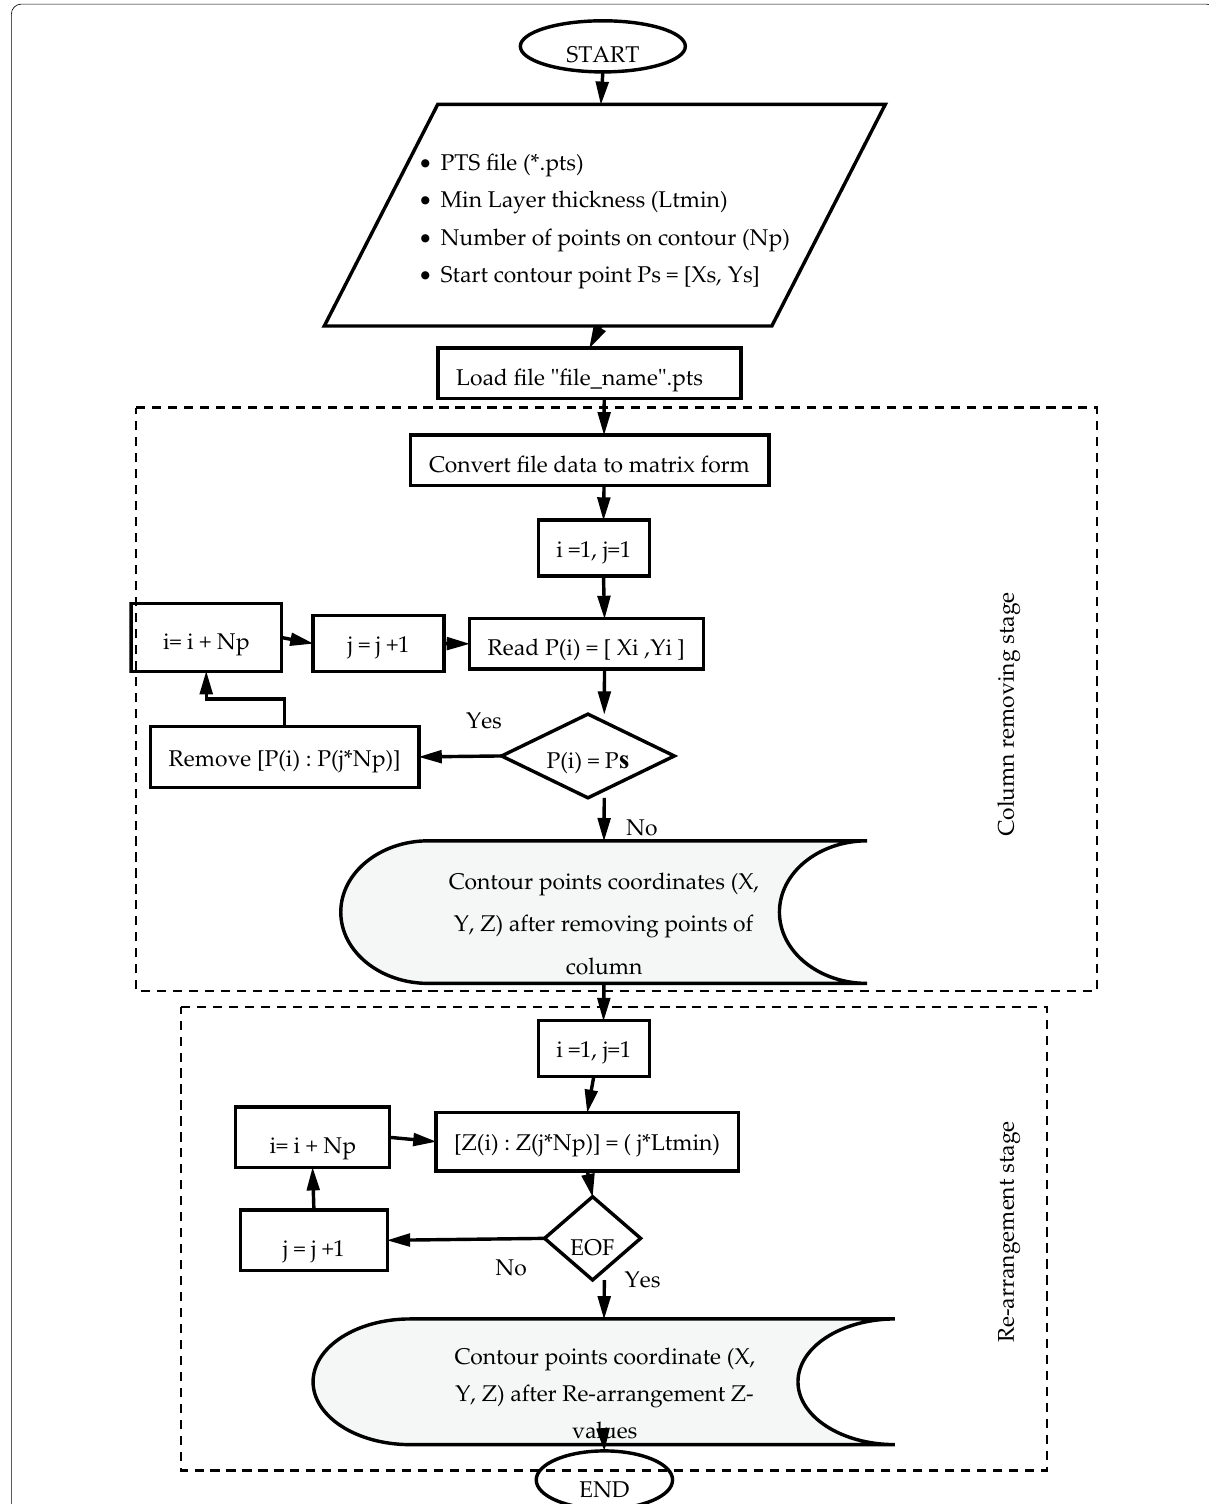
Fig. 2 Flowchart for the proposed model preparation module. The figure shows the two stages of model preparation which called Column Removing Stage and Rearrangement Z-Values